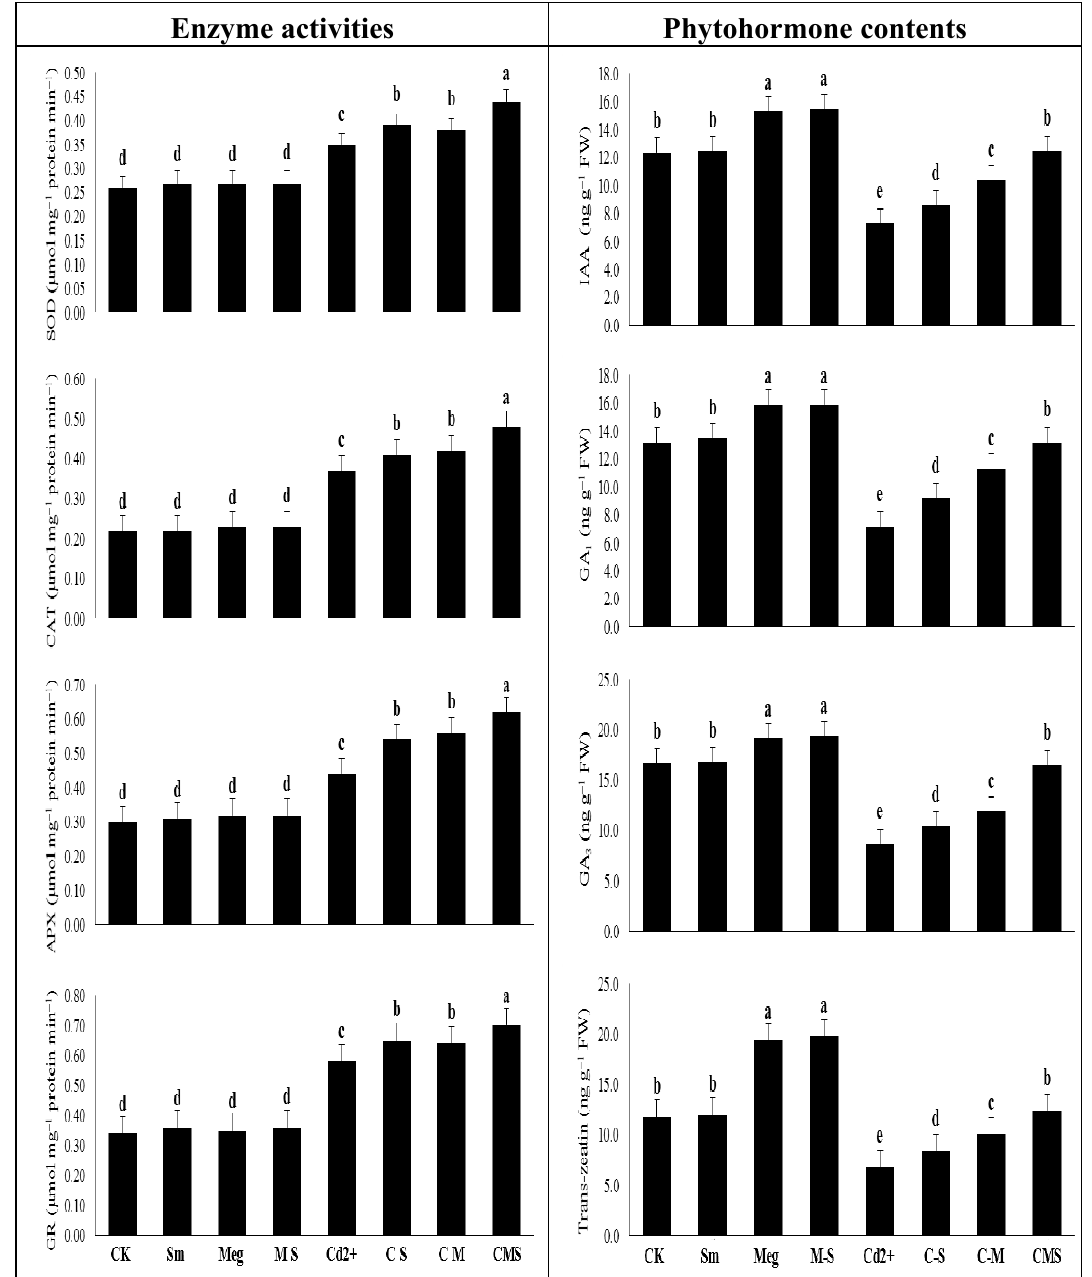
Figure 4. Response of enzyme (superoxide dismutase (SOD), catalase (CAT), ascorbate peroxidase (APX), and glutathione reductase (GR)) activities, as well as leaf phytohormone levels (indole-3-acetic acid (IAA), gibberellic acids 1 and 3 (GA1 and GA3), and cytokinin (trans-zeatin)) of maize plants to foliar application of silymarin (Sm), maize grain extract (MEg), or silymarin-enriched maize grain extract (MEg-Sm) under Cd stress. The same letters on the bars (mean ± SE) of the parameters indicate nonsignificant differences, whereas the significant differences are a result of different letters according to the least significant difference (LSD) test ( P ≤ 0.05). CK = control, Sm = silymarin, Meg = maize grain extract, M-S = silymarin-enriched maize grain extract, C-S = Cd+Sm, C-M = Cd+Meg, CMS = Cd+Meg+Sm. Under Cd stress conditions, SOD, CAT, APX, and GR activities were markedly ele- vated by 34.6%, 68.2%, 46.7%, and 70.6% respectively, whereas the levels of IAA, GA 1 , GA 3 , and trans-zeatin were significantly decreased by 41.1%, 45.5%, 47.9%, and 42.4%, respectively, compared to the normal control (Figure